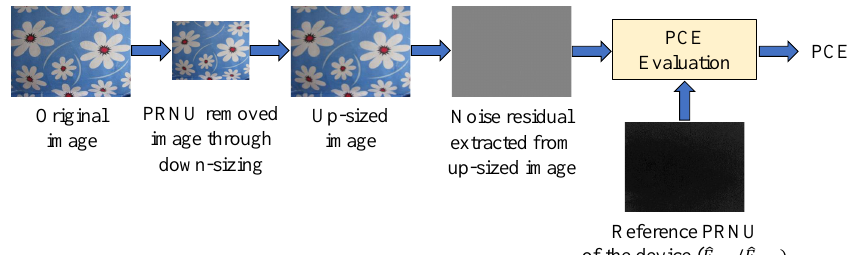
Figure 1. PRNU fingerprint removal through downsampling and removal effectiveness evaluation based on